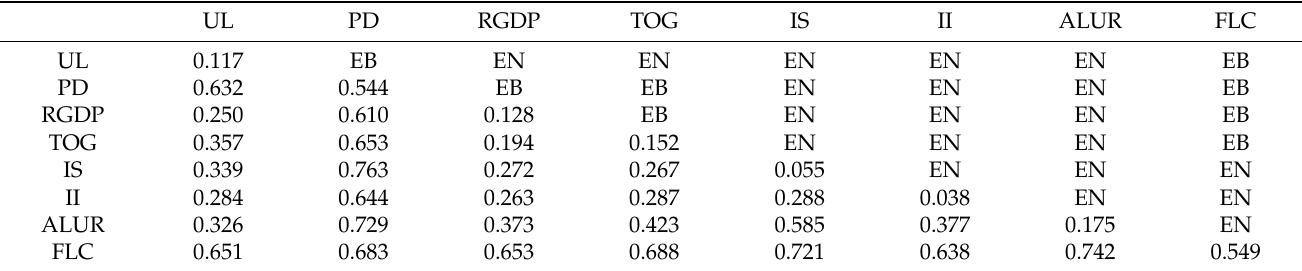
Table 5. Geodetector interactive detection